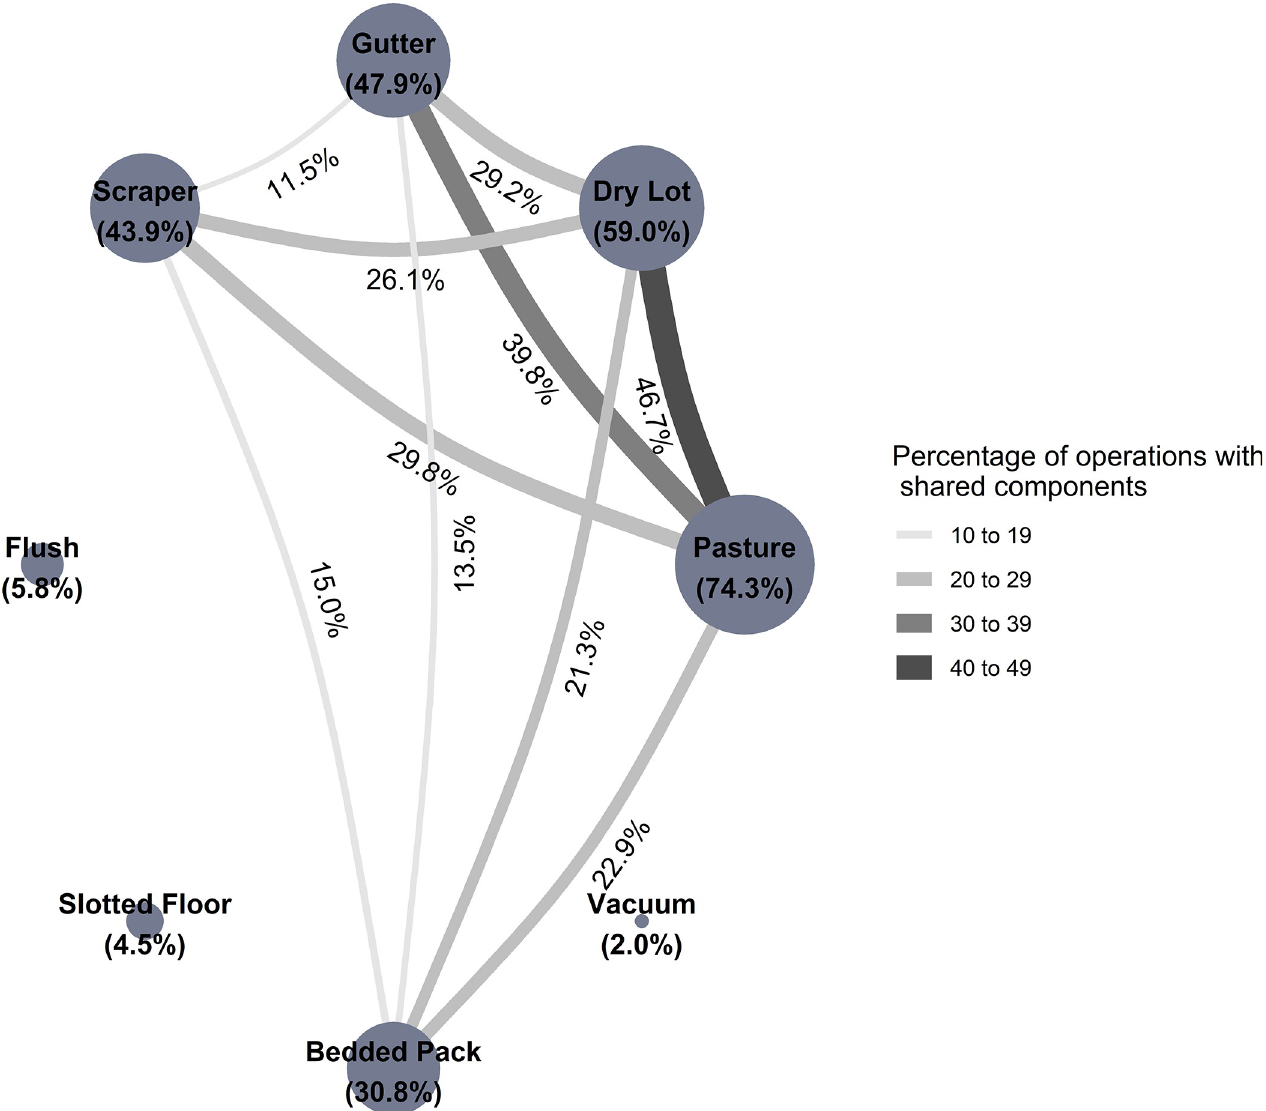
Fig 1. Network graph showing the percentage of operations practicing the given manure handling strategy (diameter of nodes) and the percentage of operations practicing a pair of strategies together (width of edges, with widths colored by group based on magnitude of percentage). Edges representing percentages of five or less were